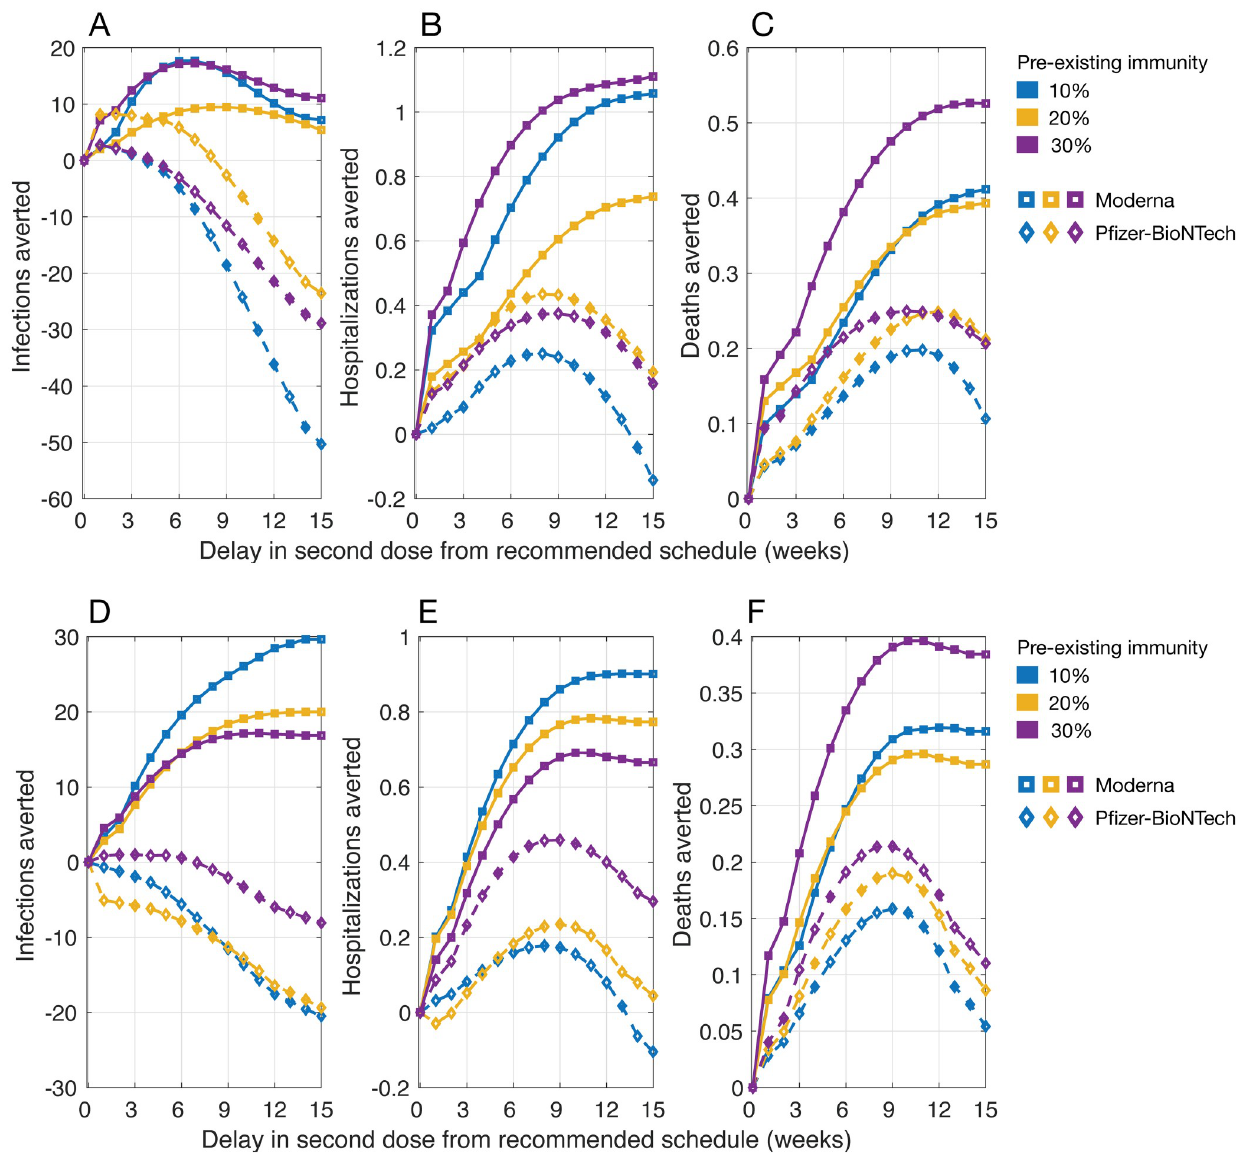
Fig 3. Projected number of infections, hospitalizations, and deaths averted per 10,000 population in a DSD vaccination program compared to the recommended schedule of 2 doses of Moderna (with a 28-day interval) and Pfizer-BioNTech (with a 21-day interval) vaccines. The daily vaccination rate was (A, B, and C) 30 doses and (D, E, and F) 45 doses per 10,000 population. Vaccine efficacy was set to the mean of estimated ranges (Fig 1), and the waning rate of first-dose efficacy was 5% per week, starting from week 7 after the first dose prior to the administration of the second dose. The individual numerical values for A–C and D–F are listed in S3 and S4 Datas, respectively. DSD, delayed second